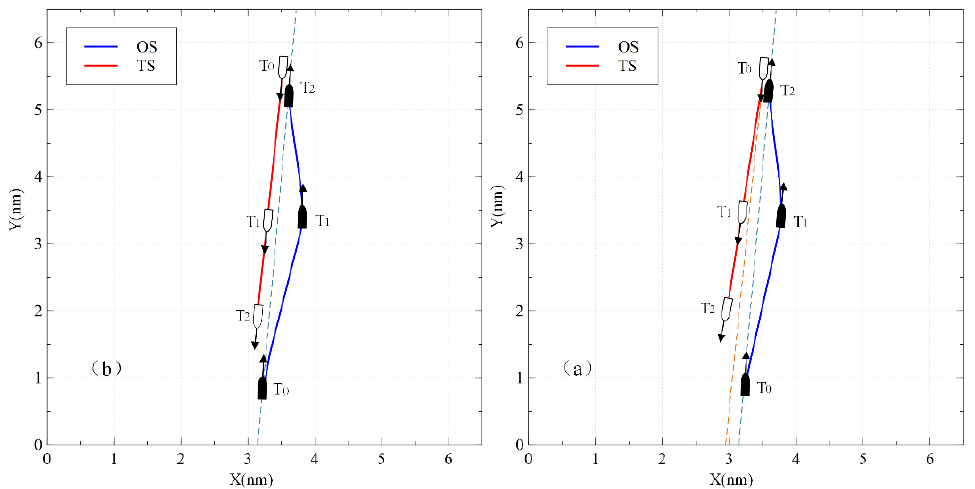
Figure 6. The trajectories of the ships in scenario 1: ( a ) trajectories of the ships in situation 1; ( b ) trajectories of the ships in situation 2.